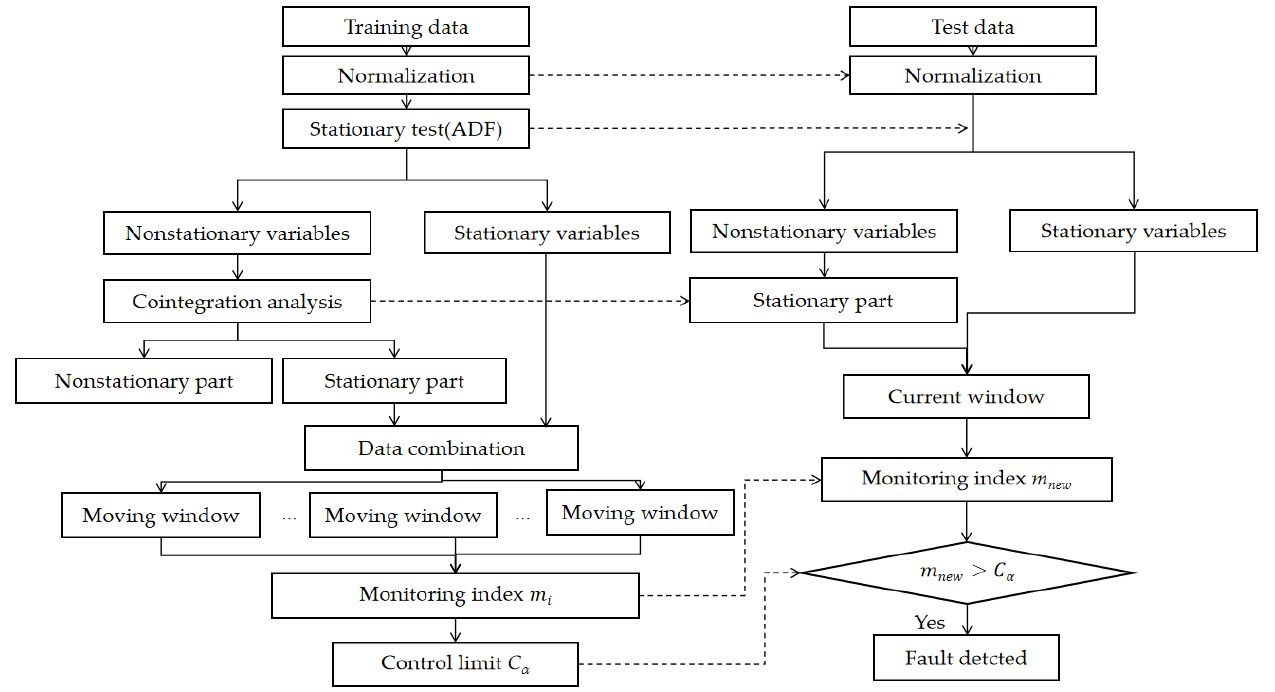
Figure 1. The diagram of the proposed monitoring method.